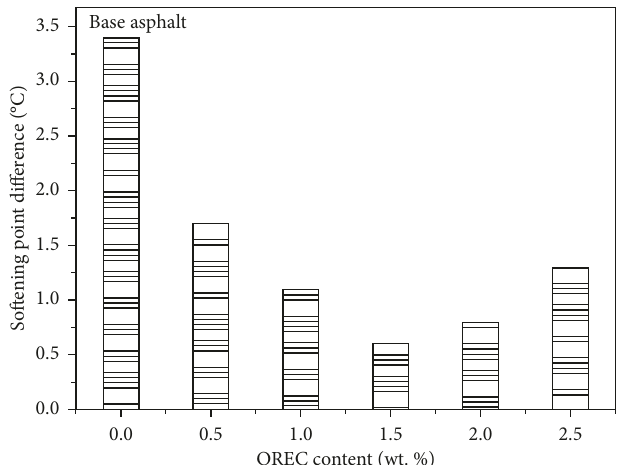
Figure 5: The softening point difference of WPP/OREC-modified asphalt with different contents of